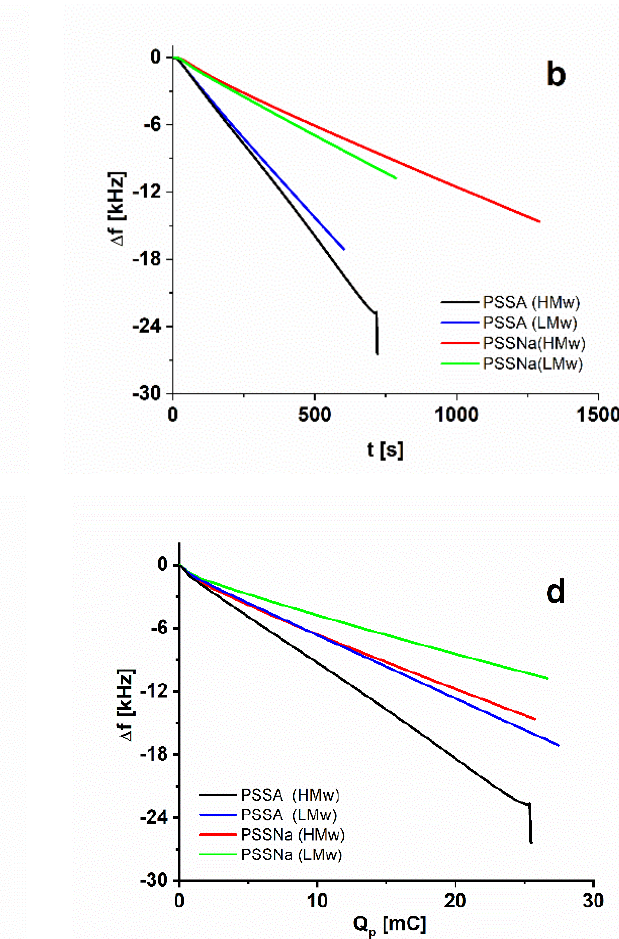
Figure 1. Current ( a ), frequency shift ( b , d ), and driving force ( c ) measurements in the course of potentiostatic polymeri- zation in the presence of i-PASA (red) t-PASA (blue), i-PASNa (green) and t-PASNa (black).